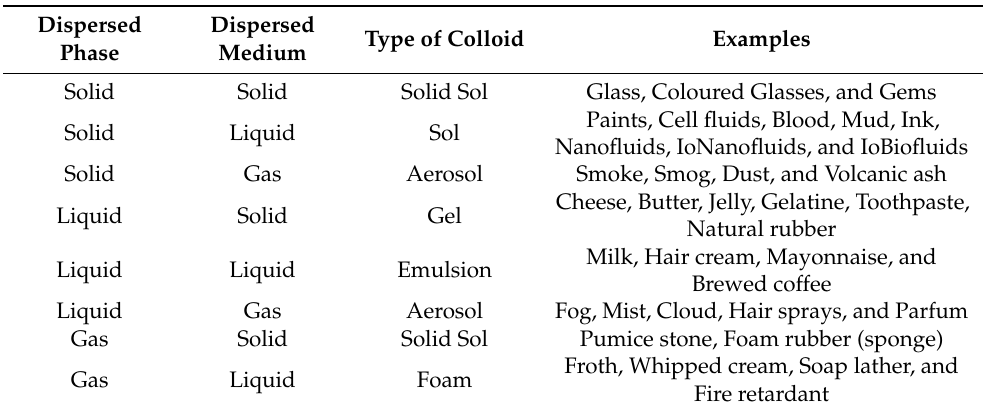
Table 1. Different types of